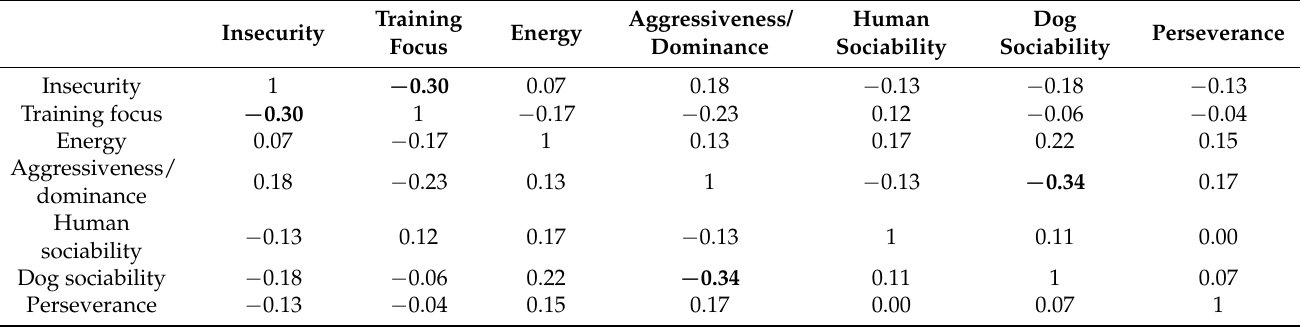
Table 5. Factor correlations in the personality